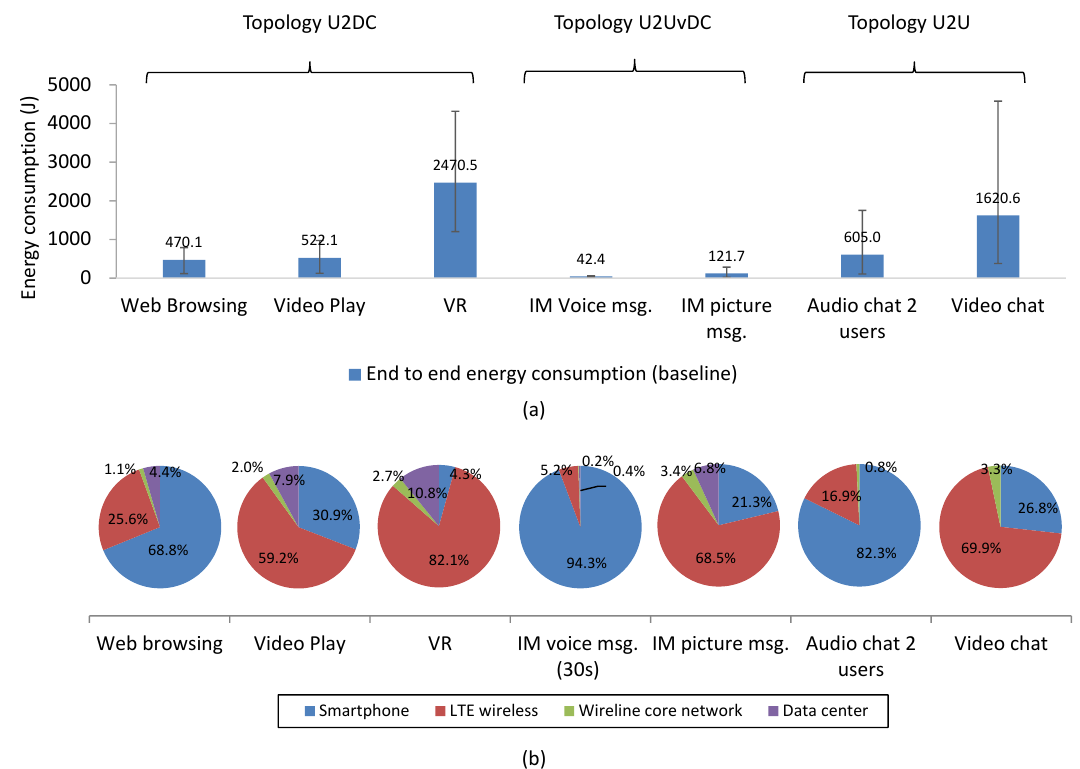
Figure 5. Baseline end-to-end energy consumption of typical mobile services. Note that a macro BS is used in the baseline energy consumption assessments. ( a ) End-to-end energy consumption under different user behaviors; ( b ) average energy breakdown of baseline. The error bars show the minimum and maximum usages of the services.